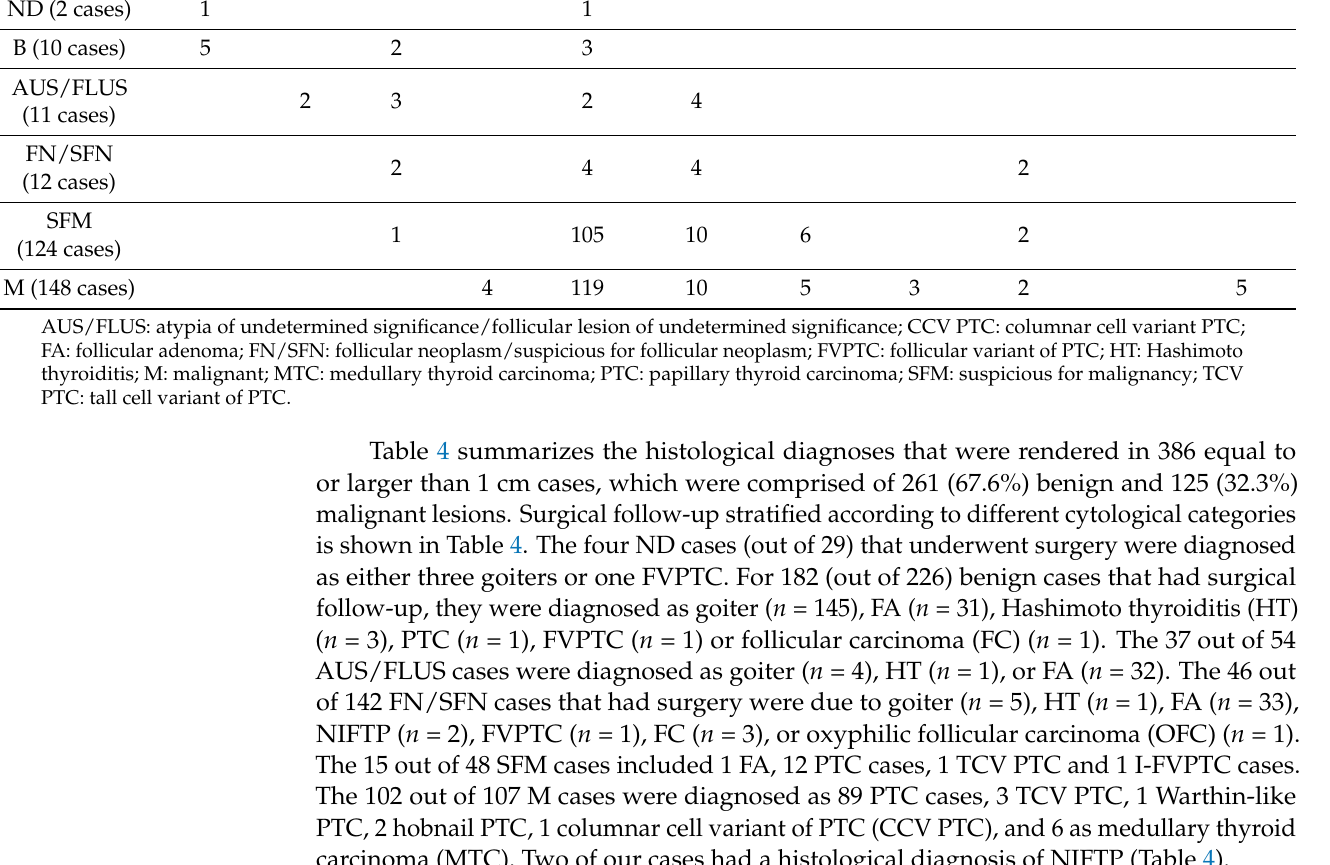
Table 3. Cytologic/histological correlation for the subcentimeter series of cases.